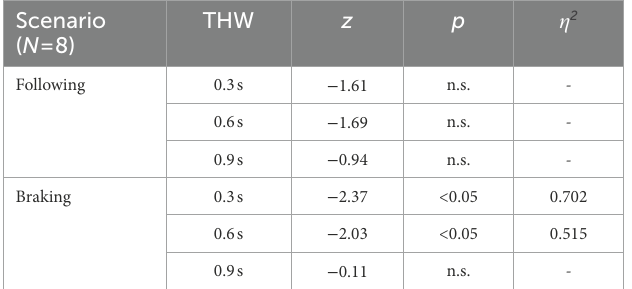
TABLE 2 Asymptotic Wilcoxon-Tests for differences of feeling exposed between “Bu” assisted and baseline rides by time headway and scenario. Scenario THW z p η 2 ( N = 8)